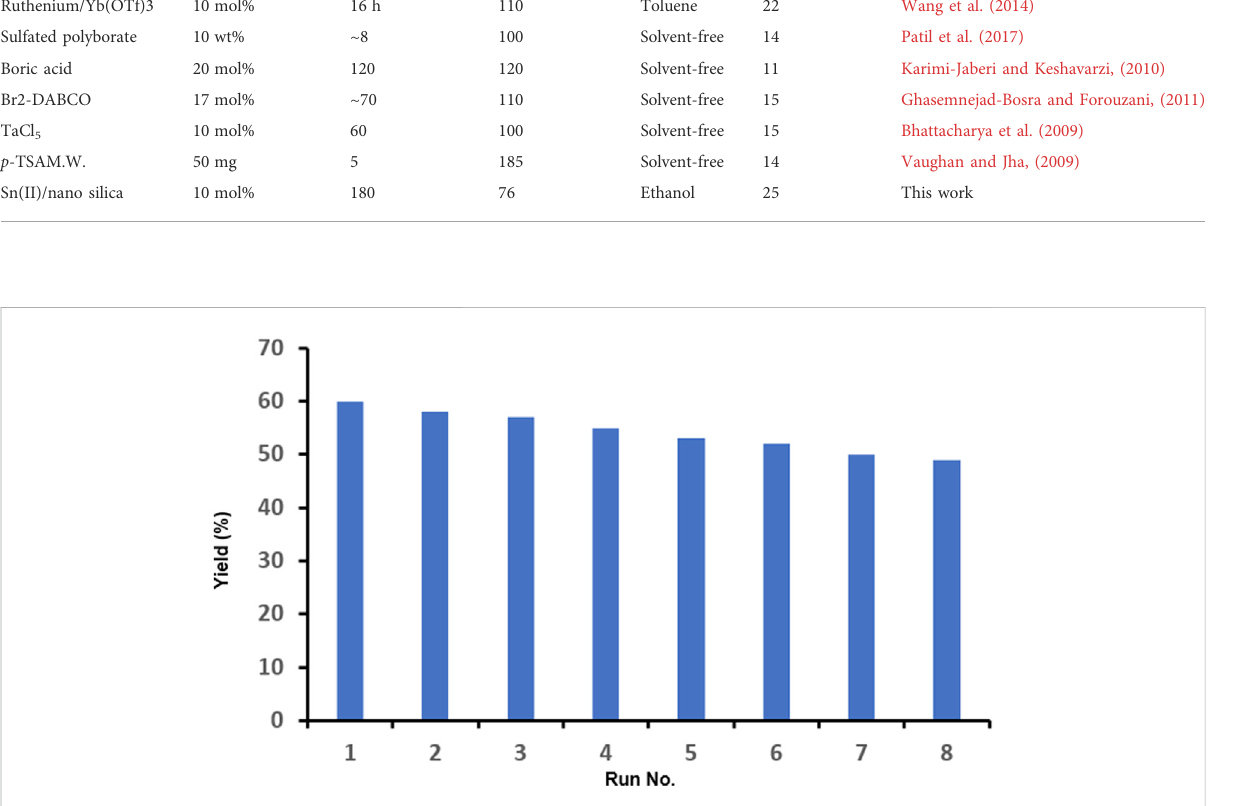
FIGURE 5 Results of the recyclability experiments for the model reaction at the optimized